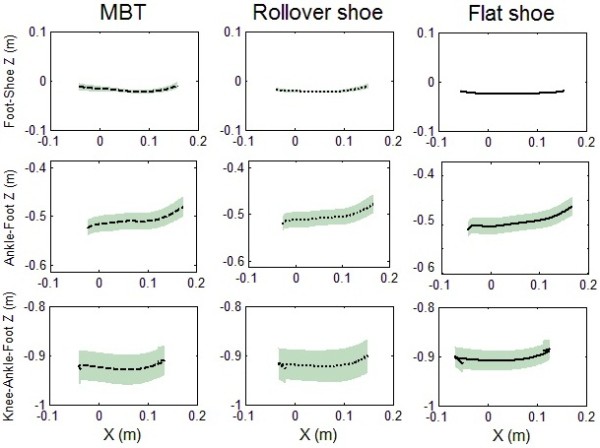
The mean ± 1standard deviation of foot-shoe, ankle–foot and knee–ankle–foot rollover shapes for MBT, Rollover shoe and Flat shoe. X and Z values: the anterior and proximal components, respectively, of the calculated rollover shapes.